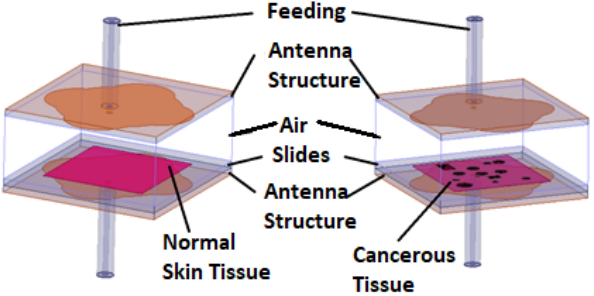
Figure 3: Designed system